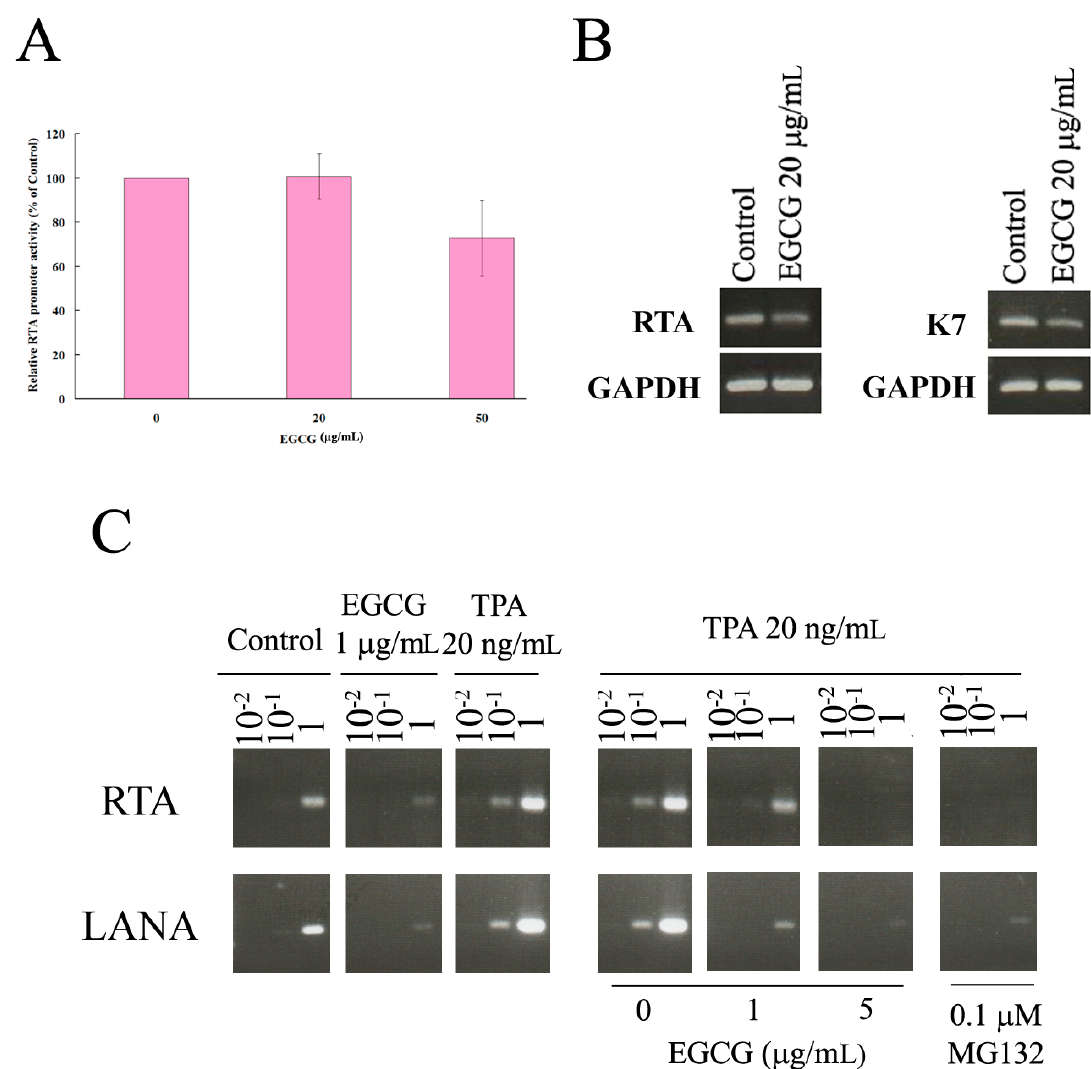
Figure 7. EGCG treatment inhibited HHV8 virus replication in PEL cells. ( A ) EGCG treatment failed to induce RTA promoter activity. 293T cells were co-transfected with 50 ng of DNA encoding RTA promoter and 2 ng of pTK-RL plasmid DNA (encoding Renilla luciferase). The RTA promoter activities were determined by the dual-luciferase reporter assay kit (Promega, Madison, WI, USA) in untreated 293T cells or 293T cells treated with EGCG (20 μ g/mL or 50 μ g/mL) for 24 h; ( B ) HHV8 lytic genes (RTA and K7) expression levels in EGCG-treated PEL cells were detected by RT-PCR; ( C ) BCBL-1 cells were treated with 1 μ g/mL EGCG or 20 ng/mL TPA for 48 h, or incubated with TPA for 24 h to induce the production of new virus particles, and then incubated with or without EGCG (1 μ g/mL and 5 μ g/mL) or MG132 (0.1 μ g/mL) for 24 h. The serial dilutions (10 − 2 , 10 − 1 and 1×) of viral genomes extracted from culture medium were quantified by PCR using HHV8 genes (RTA and LANA). The representative data are shown.